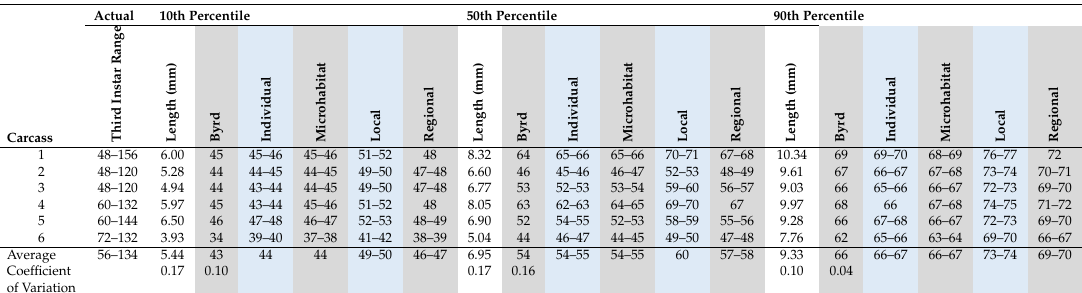
Table 6. Actual and estimated Phormia regina post-colonization intervals (PCIs) calculated using 10th, 50th, and 90th percentile third instar lengths and each temperature source, with a minimum developmental threshold of 6 ◦ C. Min, med, and max represent the minimum, median, and maximum hourly value for each PCI. All time values represent hours. White areas represent actual values, while gray and blue areas represent estimated values from published development data and body lengths